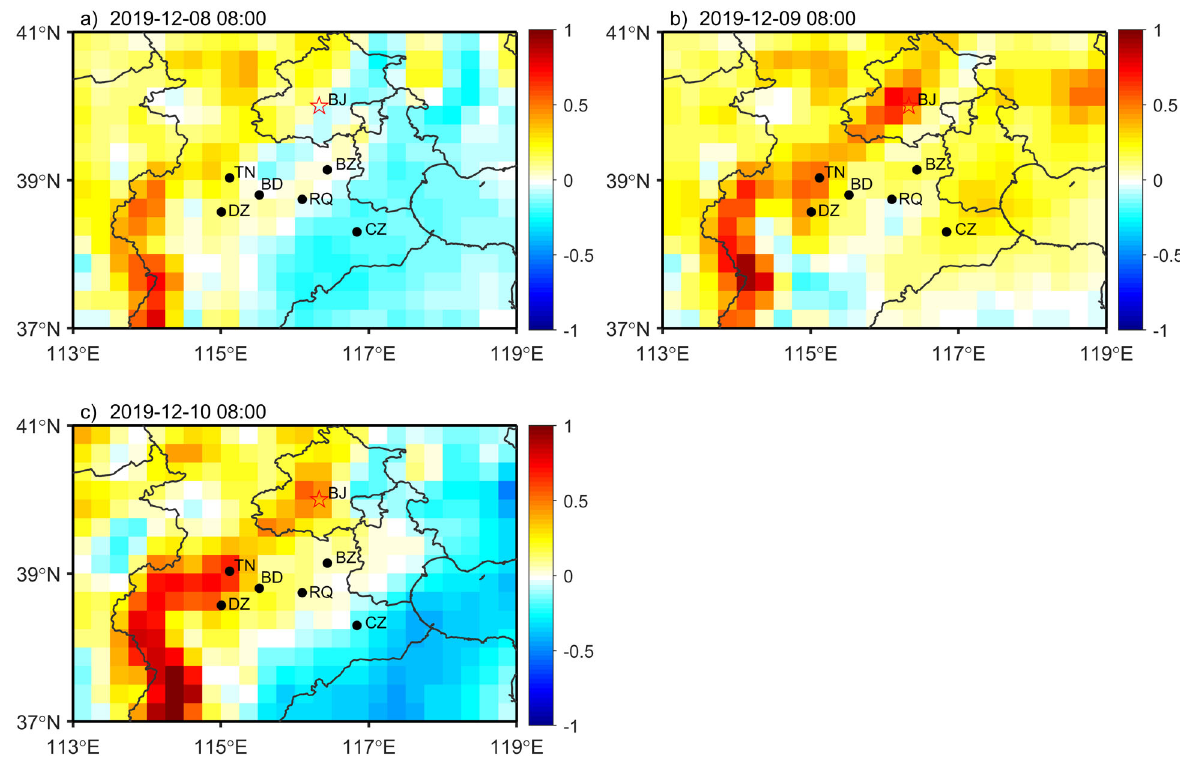
Fig. 5 Vertical velocity at 925 hPa at 8:00 LT from 8 to 10 December 2019. a – c shows the vertical velocity (unit: Pa s − 1 ) on 8, 9, and 10 December,